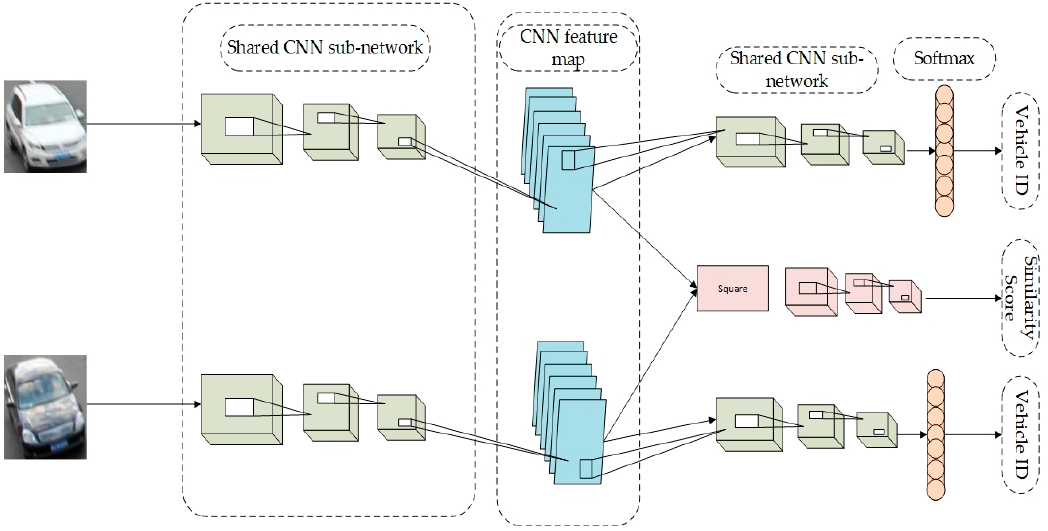
Figure 5. Siamese neural network (SNN ‐ ) based classifier.